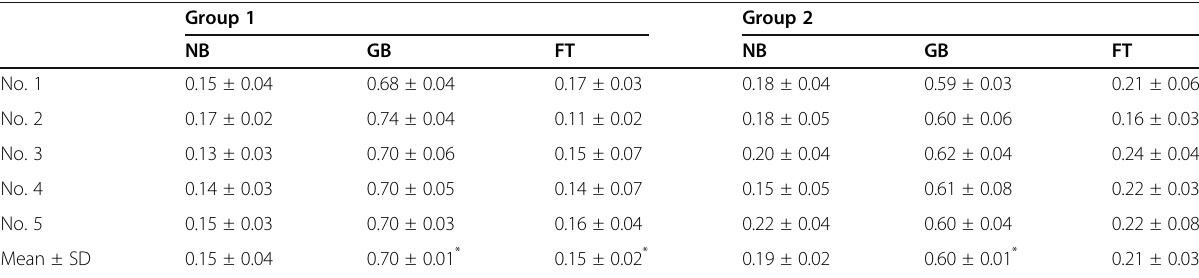
Table 1 Histologic analysis of groups 1 and 2 Group 1 Group